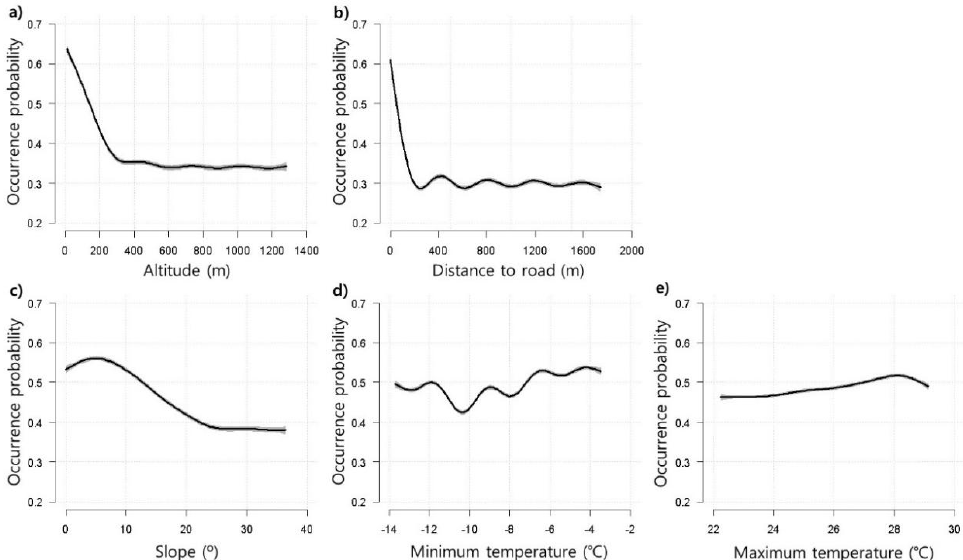
Figure 8. Partial dependence of occurrence probability of Metcalfa pruinosa against the changes of each environmental variable in the RF model. ( a ) Altitude, ( b ) distance to road, ( c ) slope, ( d ) minimum temperature in January, and ( e ) maximum temperature in July. Solid lines represent averages and gray areas display the 95% confidence interval.